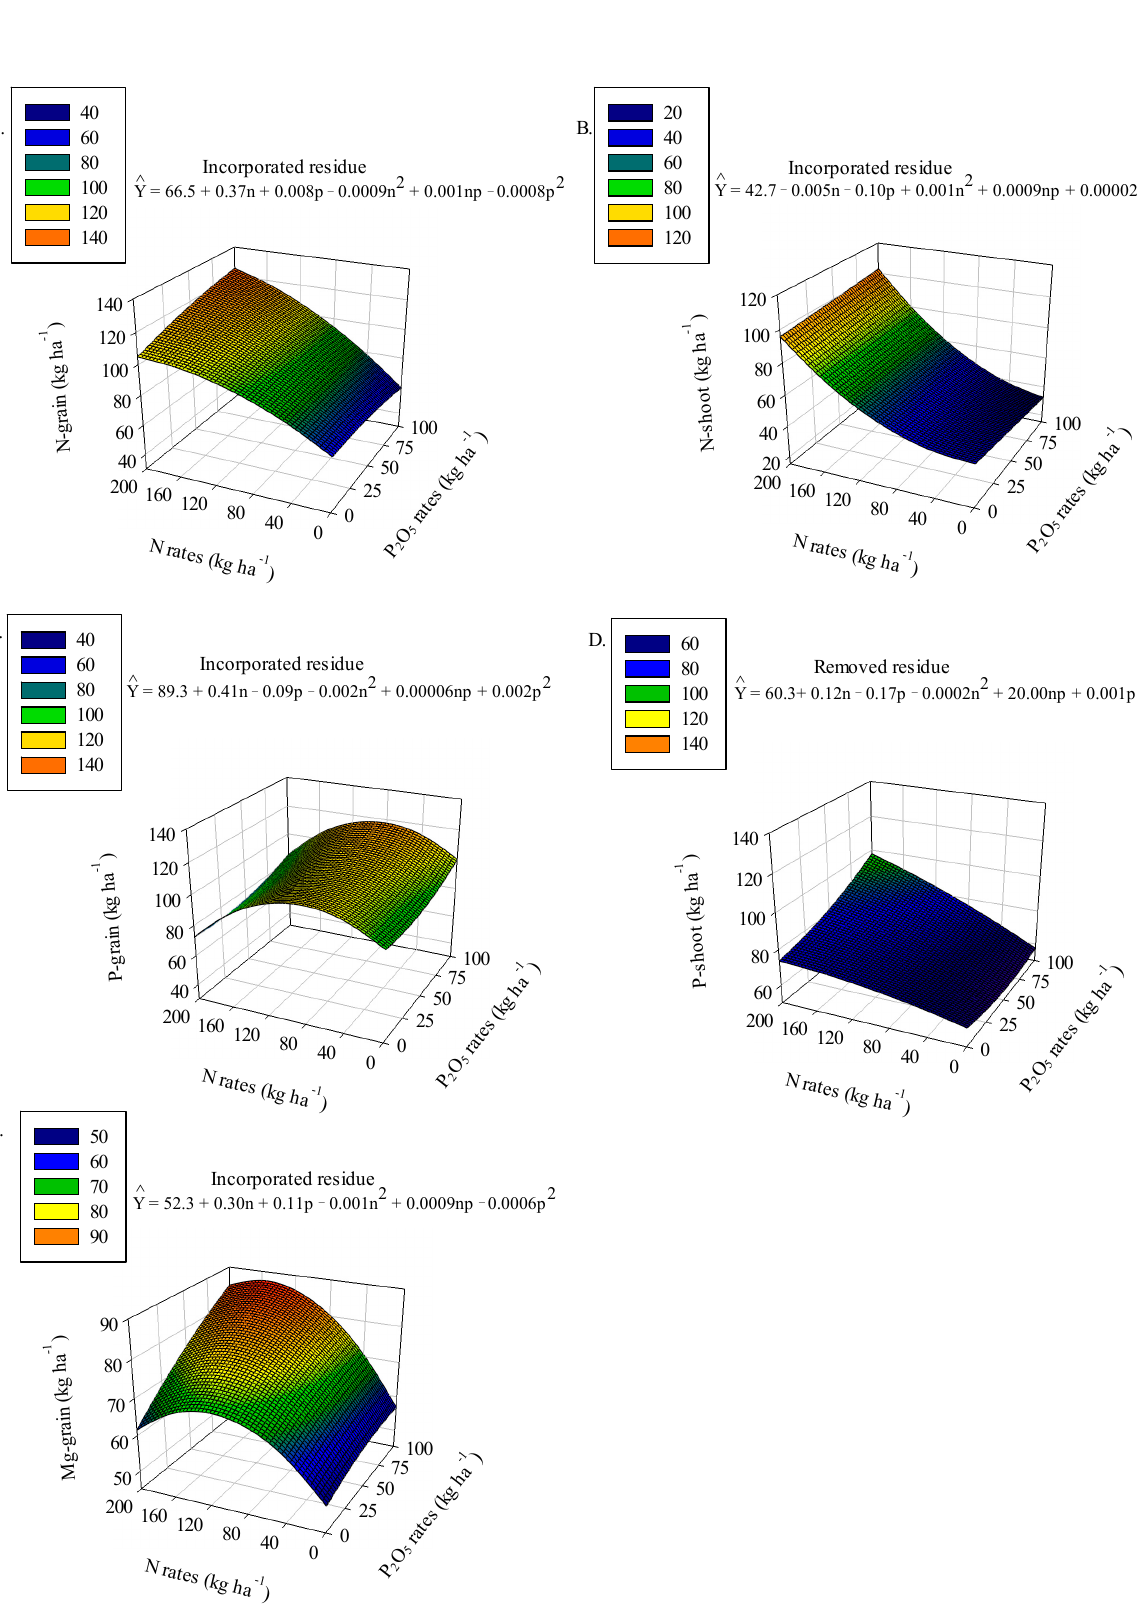
Figure 3. N-grain ( A ), N-shoot ( B ), P-grain ( C ) under incorporated residue management, P-shoot ( D ) under removed residue management, and Mg-grain ( E ) under incorporated residue management in 2013 and 2014 as a function of N and P 2 O 5 rates. P 2 O 5 linearly to the P 2 O 5 application rate, while in 2014, there was no response to P application